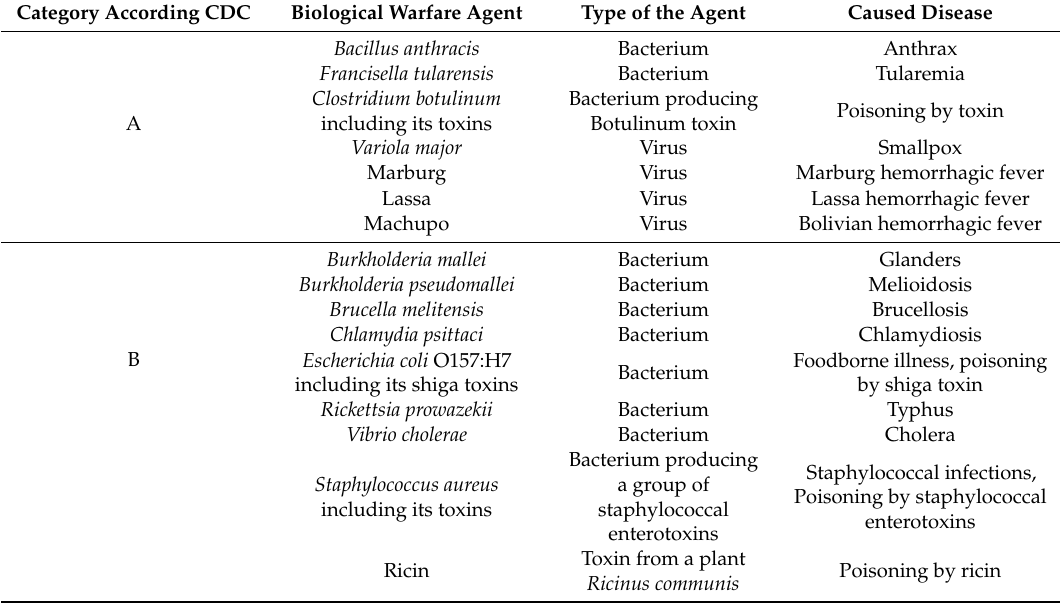
Table 1. Survey of important biological warfare